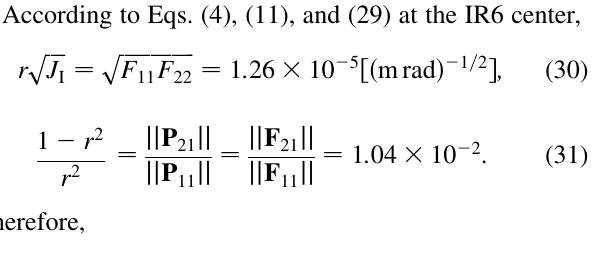
Table III lists the locations of eigenmode I’s waists and